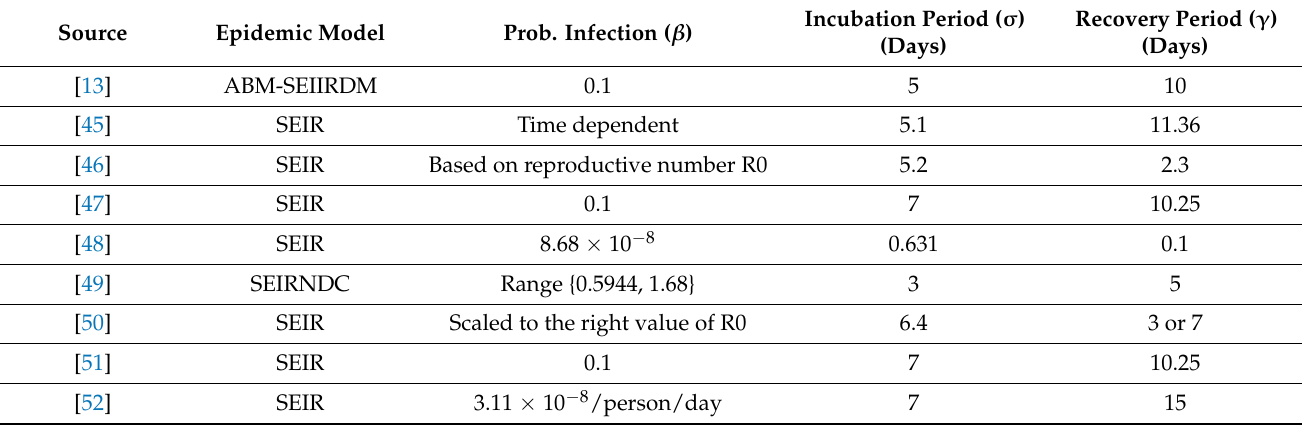
Table A10. Probability infectious value ( β ) comparison between different research projects.